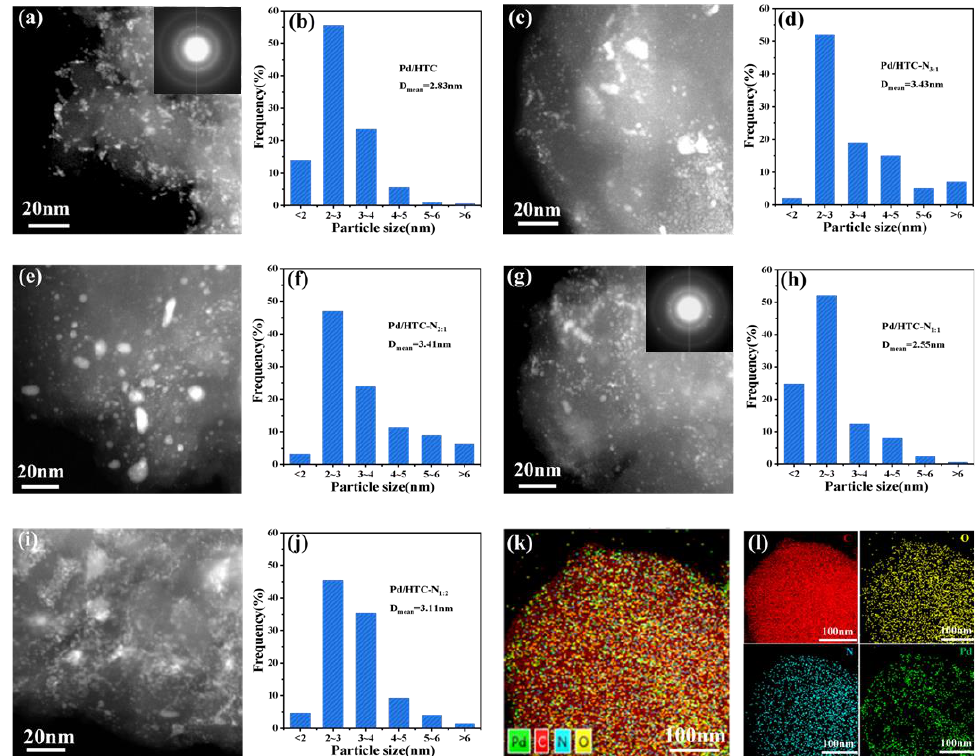
Figure 7. STEM images and the Pd particle size distributions of Pd / HTC ( a , b ), Pd / HTC-N 3:1 ( c , d ), Pd / HTC-N 2:1 ( e , f ), Pd / HTC-N 1:1 ( g , h ), and Pd / HTC-N 1:2 ( i , j ), and the elemental mapping of Pd / HTC-